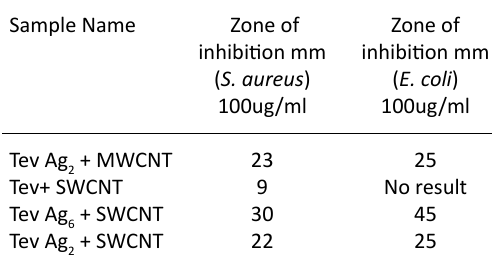
table 1 . Zone inhibitions of different nanoparticle samples against S. aureus and E.